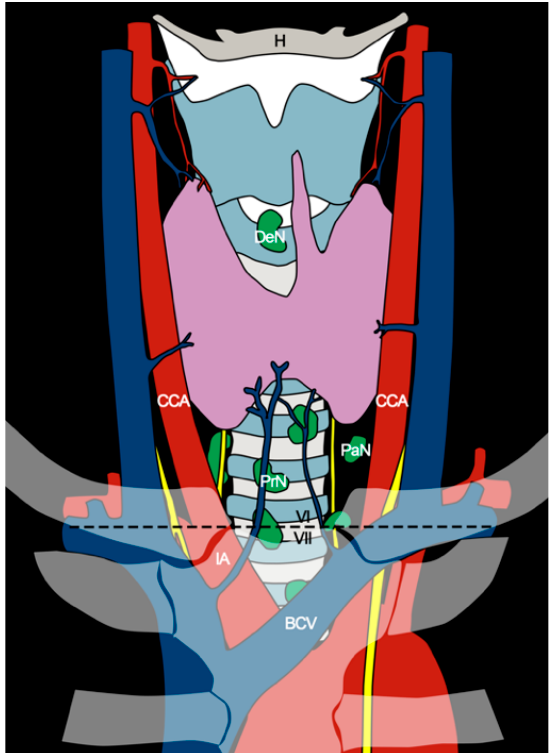
Figure 1. Anatomical diagram of the central neck compartment. The axial plane passing through the sternal notch (black dashed line) separates levels VI and VII. CCA, common carotid artery; DeN, Delphian node; H, hyoid bone; IA, innominate artery; BCV, brachiocephalic vein; PaN, paratracheal nodes; PrN, pretracheal nodes.